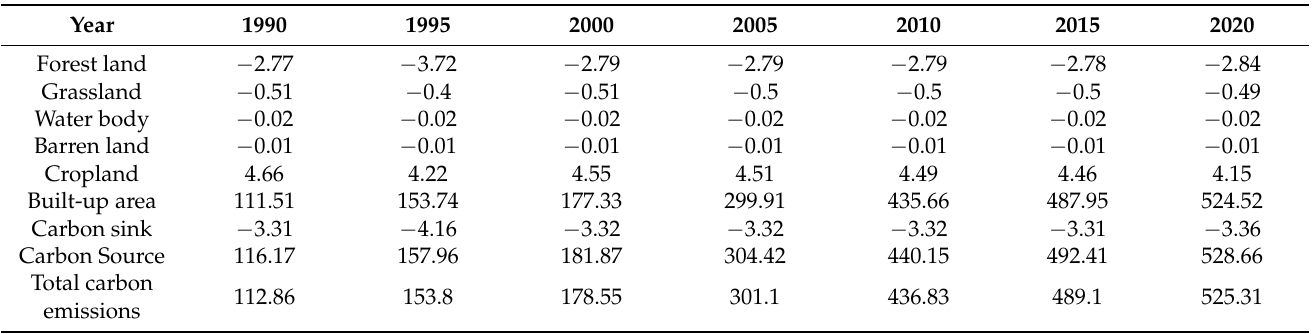
Table 3. Carbon emissions from land use change in the Beijing-Tianjin-Hebei region during 1990–2020 (million